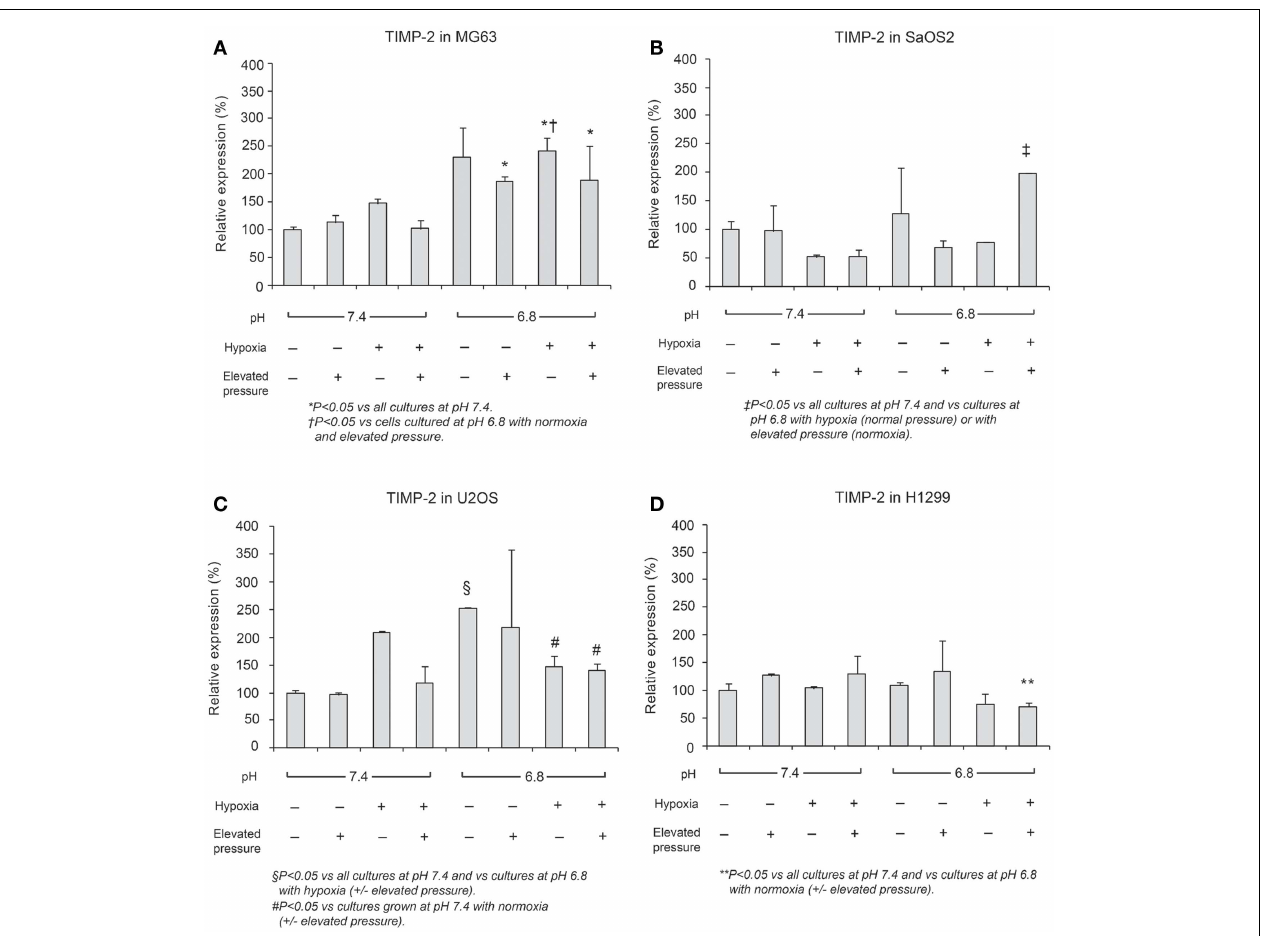
FIGURE 7 | Relative expression levels ofTIMP-2 mRNA, determined via quantitative real-time PCR, in four tumor cell lines: (A) MG63, (B) SaOS2, (C) U2OS, and (D) H1299 .